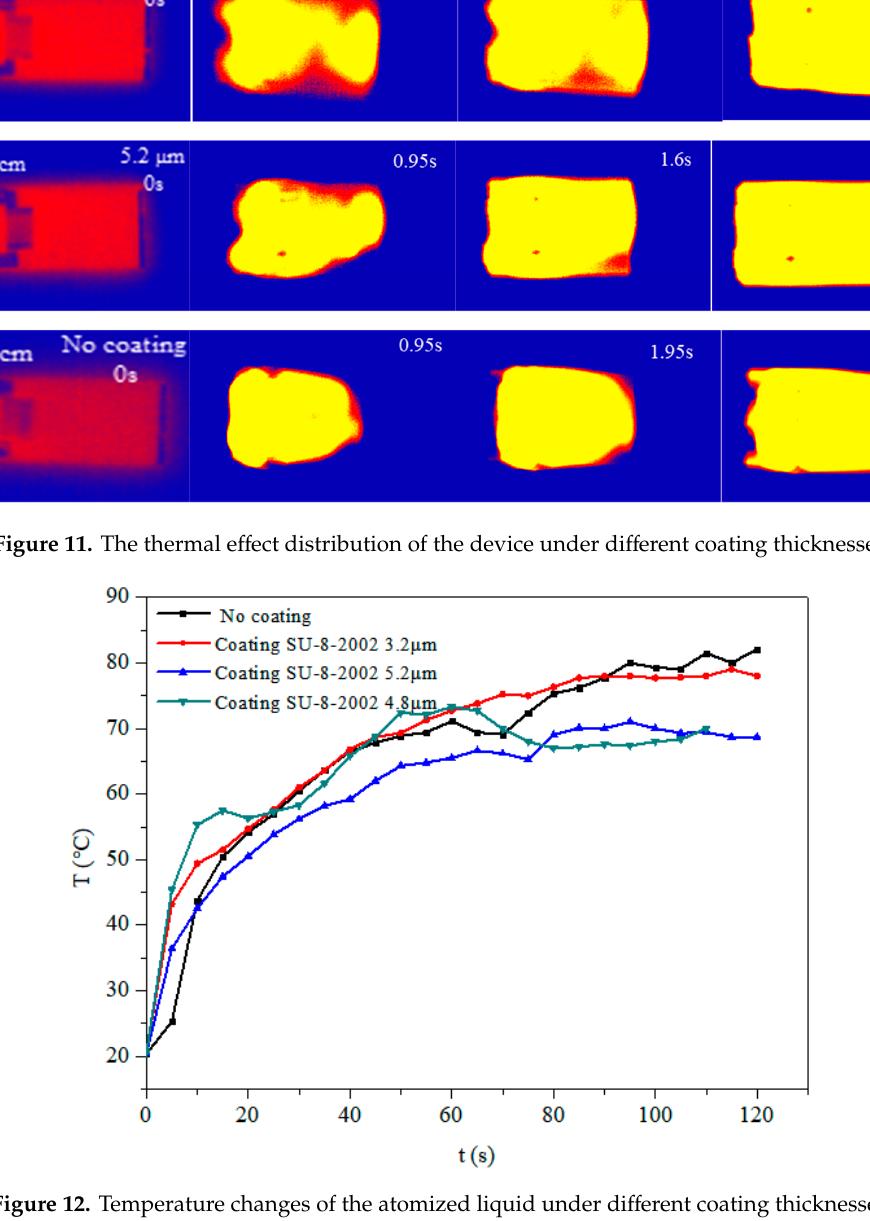
Figure 12. Temperature changes of the atomized liquid under different coating thicknesses.